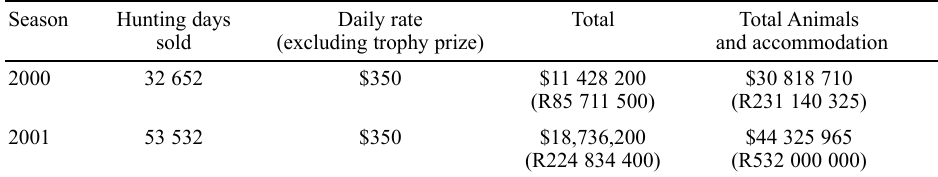
Table 6 Income: trophy hunting and accommodation